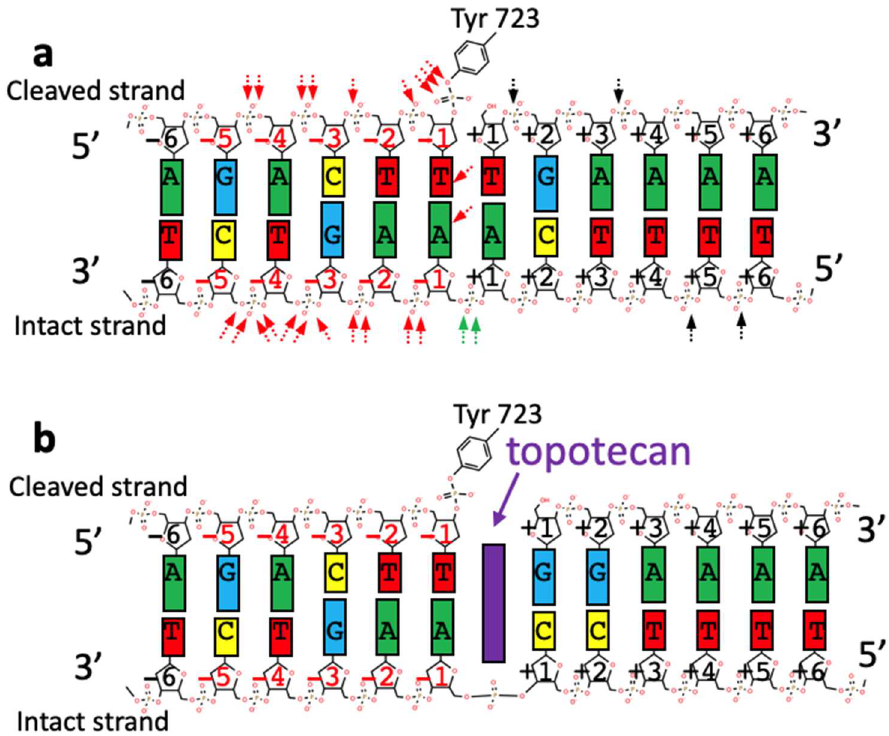
Figure 2. Simplified schematics of twelve base-pairs of DNA in TOP1 DNA-cleavage complexes. ( a ) Simplified schematic of the central twelve base-pairs of DNA in a Top1 DNA-cleavage complex (based on 2.1Å structure pdb code: 1a31). Interactions (<3.5Å) between the protein and the DNA are represented by arrows (adapted from Figure 4–, panel G in [59]). Tyrosine 723 from Top1 has cleaved the top strand. Top1 can be imagined as a hand holding the double-stranded DNA up-stream of the DNA-cleavage site (red arrows and–red numbered nucleotides) and allowing controlled rotation about the phosphodiester bond between the −1 and +1 nucleotides on the intact strand (two green arrows) to relax the DNA. ( b ) A simplified schematic of the same DNA sequence in a complex with topotecan (a camptothecin derivative). The figure is based on the 2.1Å structure with topotecan (pdb code 1K4T). Note the +1 G-C base-pair (in 1K4T). The topotecan occupies the ‘same’ space as the +1 nucleotide pair in panel a. ‘The intercalation binding site is created by conformational changes of the phosphodiester bond between the +1 and −1 base pairs of the intact strand’ [45].